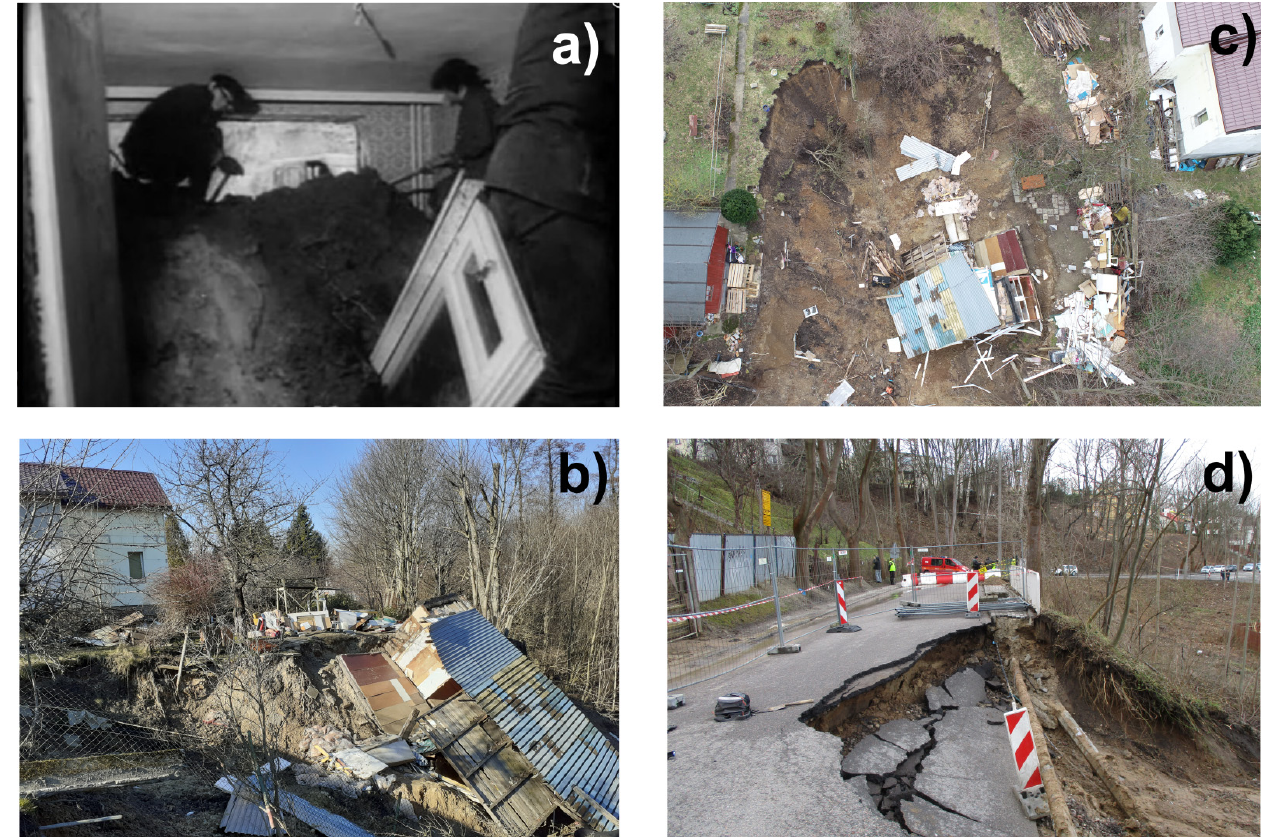
Figure 3. ( a ) Earth slide in Biskupia Górka, Gda ń sk (http://kronikarp.pl, 1981 (accessed on 16 May 2016)); ( b , c ) earth slide and earthflow in Karwiny, Gda ń sk March 2022 (photograph by Maciaszek and Ma ł ka); ( d ) damage road caused by landslide in Kamienna Góra, Gdynia February 2017 (photograph by Jurys).